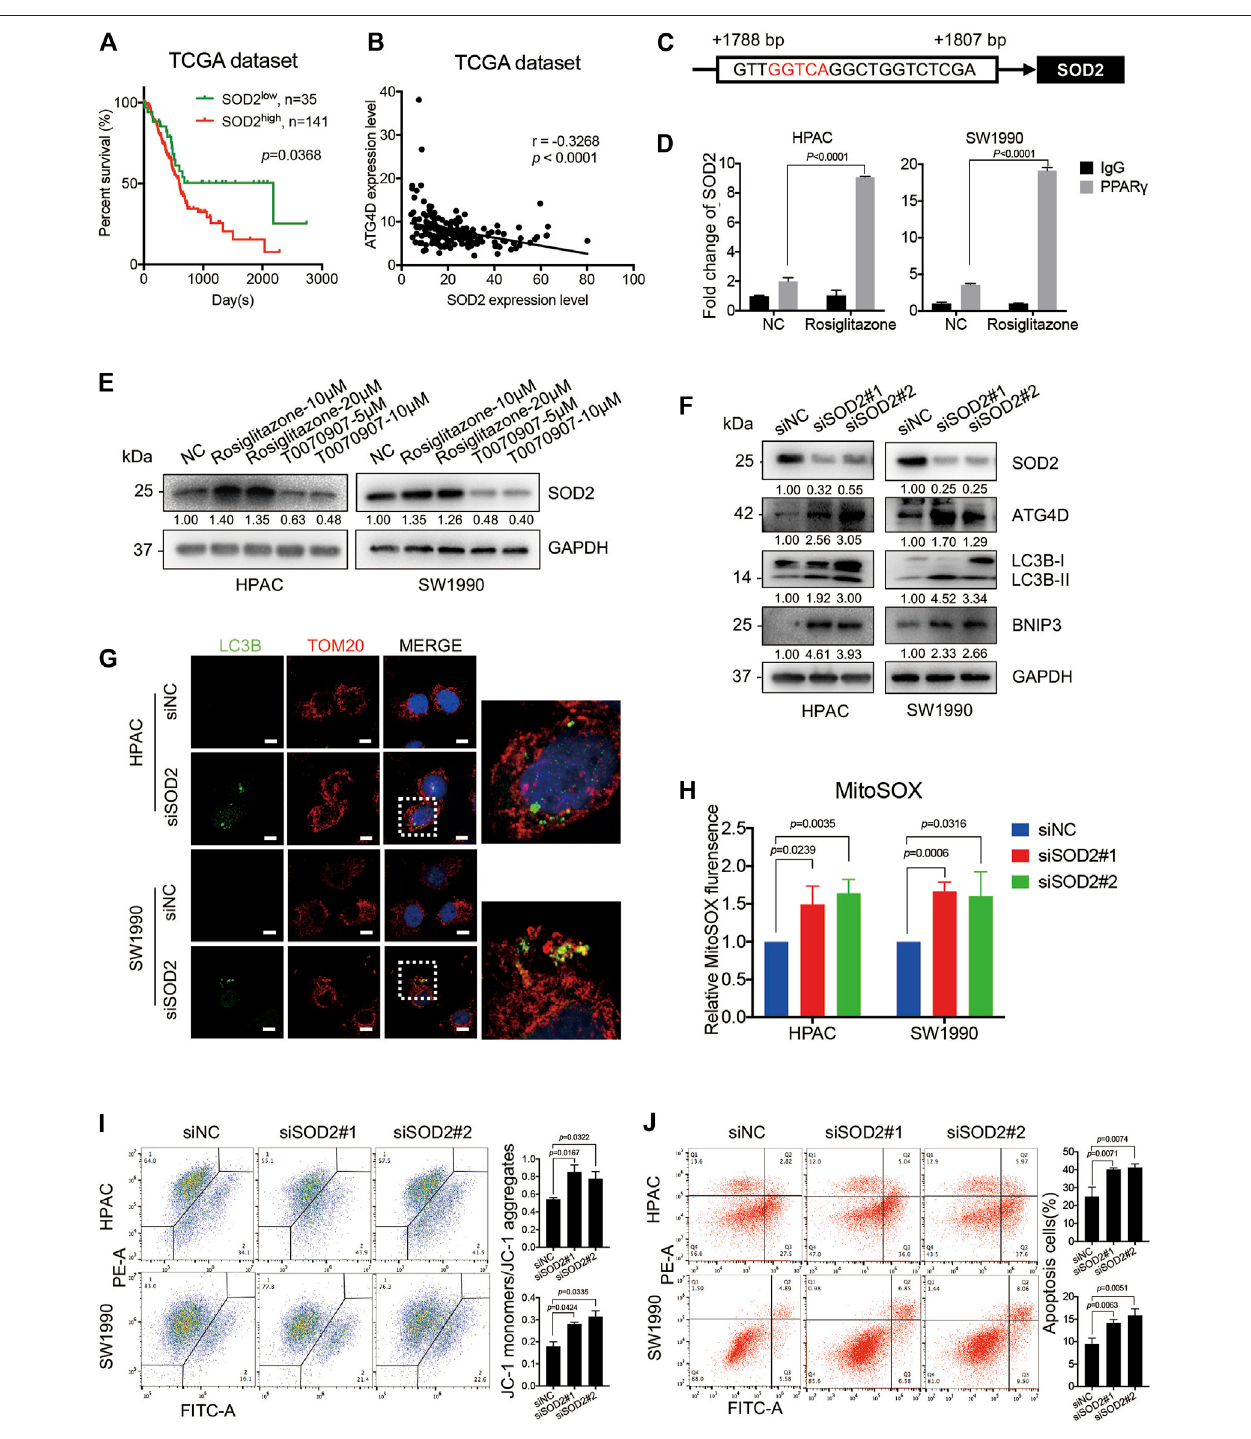
FIGURE 6 | PPAR γ inhibits ATG4D-mediated mitophagy via upregulating SOD2. (A) In TCGA dataset, The PDAC patients with SOD2 high expression suffered from shorter overall survival time than those with SOD2 low expression ( p = 0.0368). (B) Analysis of TCGA data showed the expression of SOD2 and ATG4D had signi fi cant negative correlation ( r = — 0.3268, p < 0.0001). (C) The promoter regions of SOD2 contained PPAR response element (PPRE) (red letter). (D) ChIP assay con fi rmed that PPAR γ regulated directly the transcription of SOD2 in HPAC and SW1990 cells. (E) Treating HPAC or SW1990 cells with negative control, Rosiglitazone (10, 20 μ M) or T0070907 (5, 10 μ M) for 72 h affected the expression level of SOD2. (F) Knockdown of SOD2 by siRNA in HPAC and SW1990 cells increased the expression of ATG4D, LC3B-II and the apoptosis-related protein expression-BNIP3. (G) Knockdown of SOD2 by siRNA in HPAC and SW1990 cells